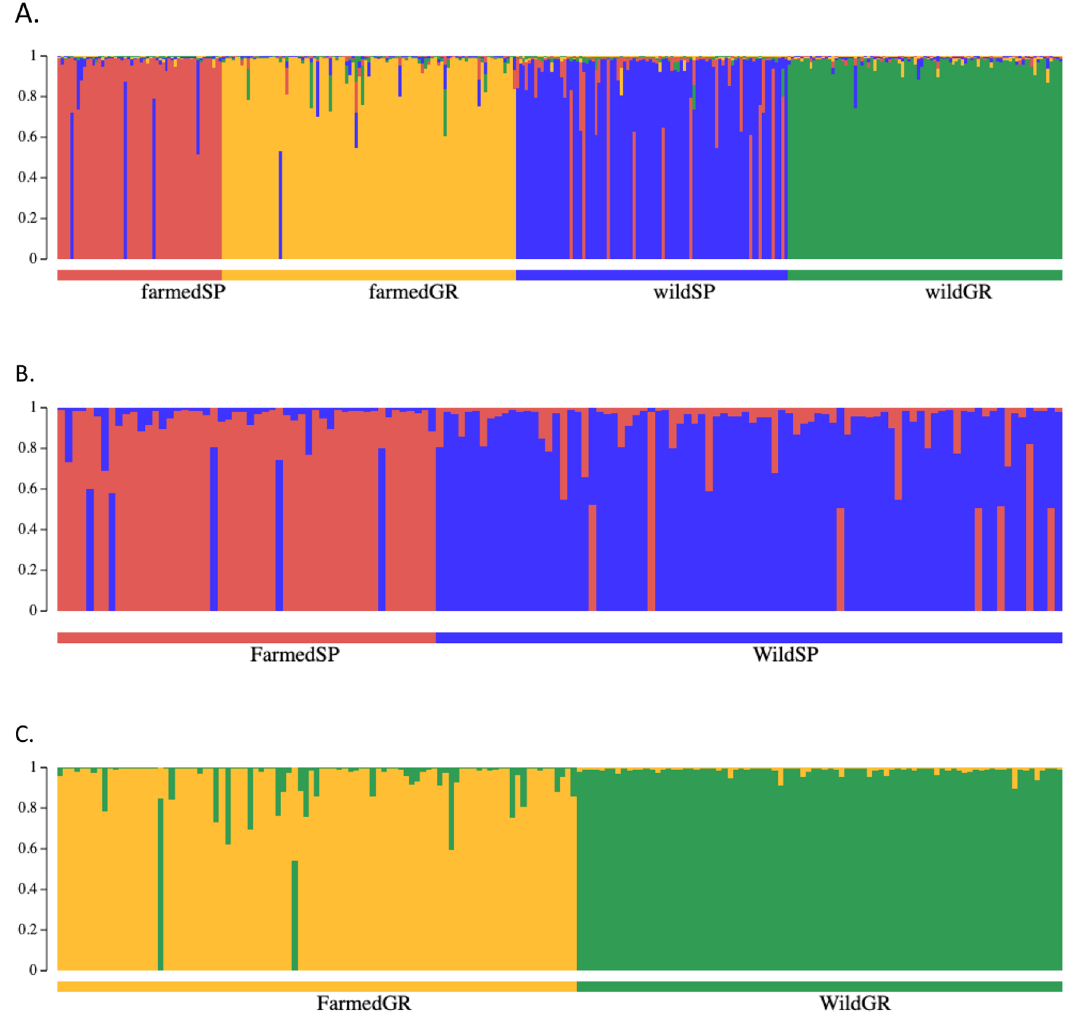
Fig. 4. Bayesian clustering of D . labrax samples. A. All four samples. B. Spanish samples. C. Greek samples. The different colors represent the groups that the program STRUCTURE has clustered the individuals. The length of the colored bar shows the probability that a speci fi c individual belongs to the respective group. The length of the colored bars per individual adds up to